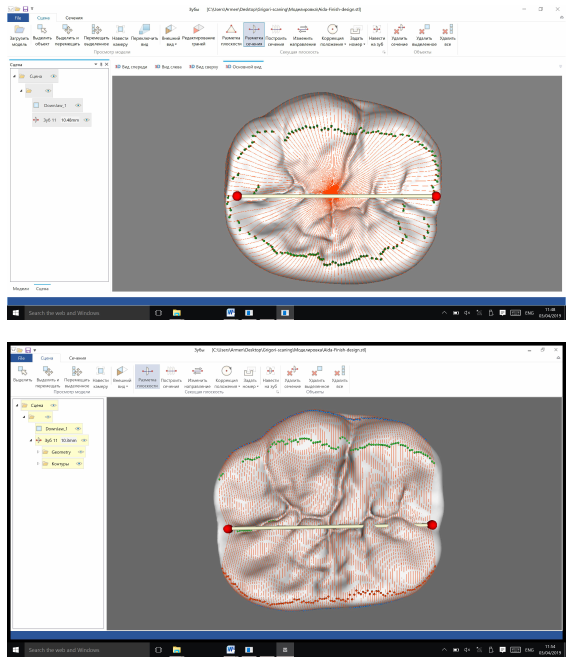
Figure 6. Multidirectional digital modelled crown sectioning